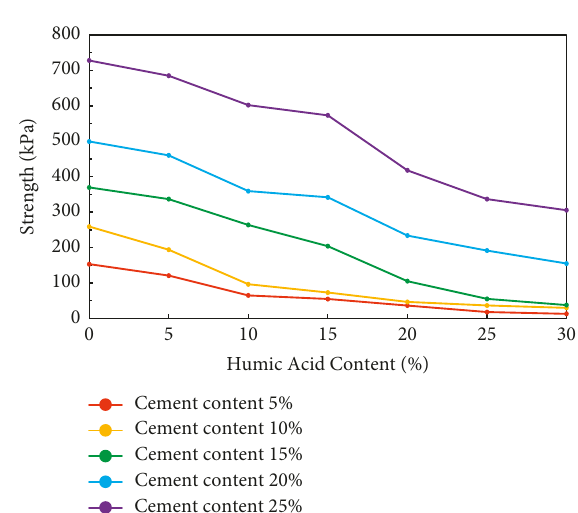
Figure 6: Relationship between the strength and the amount of humic acid with 365d